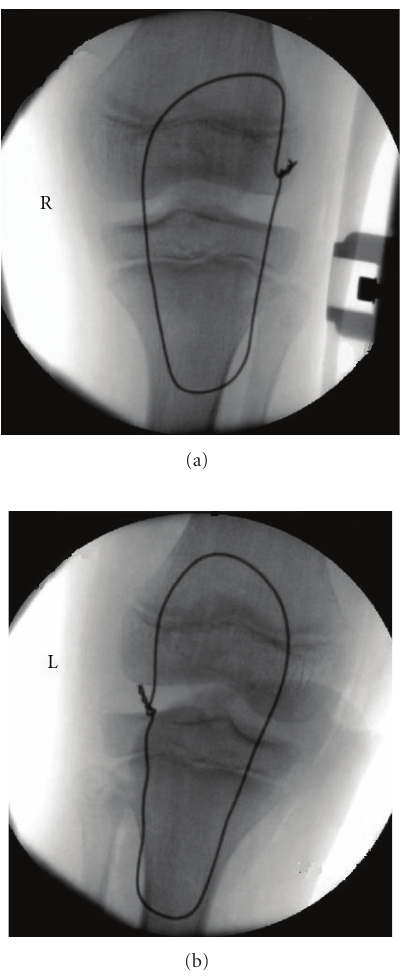
Figure 4: (a) Intra-operative image of the right knee. (b) Intra- operative image of the left